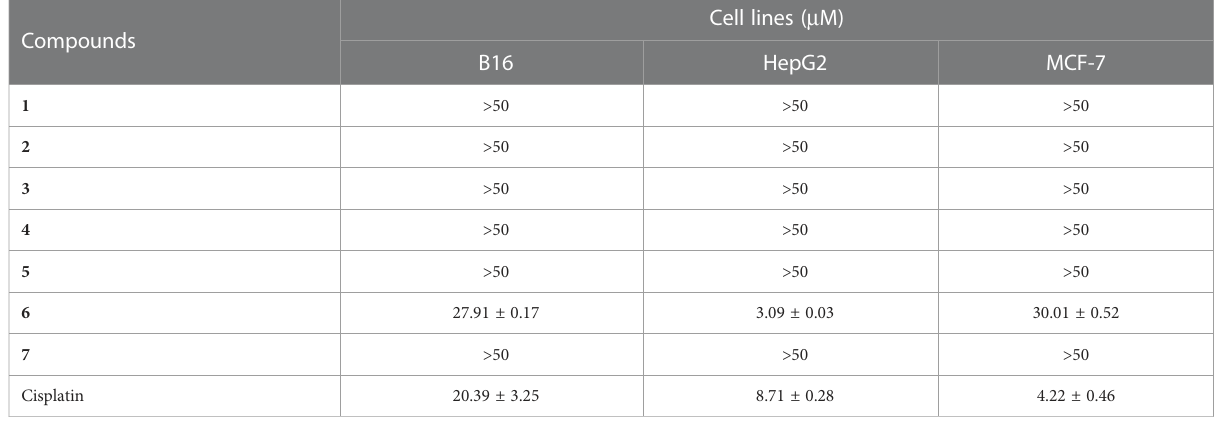
TABLE 3 Cytotoxicity data of compounds 1 − 7 against the tumor cell lines.